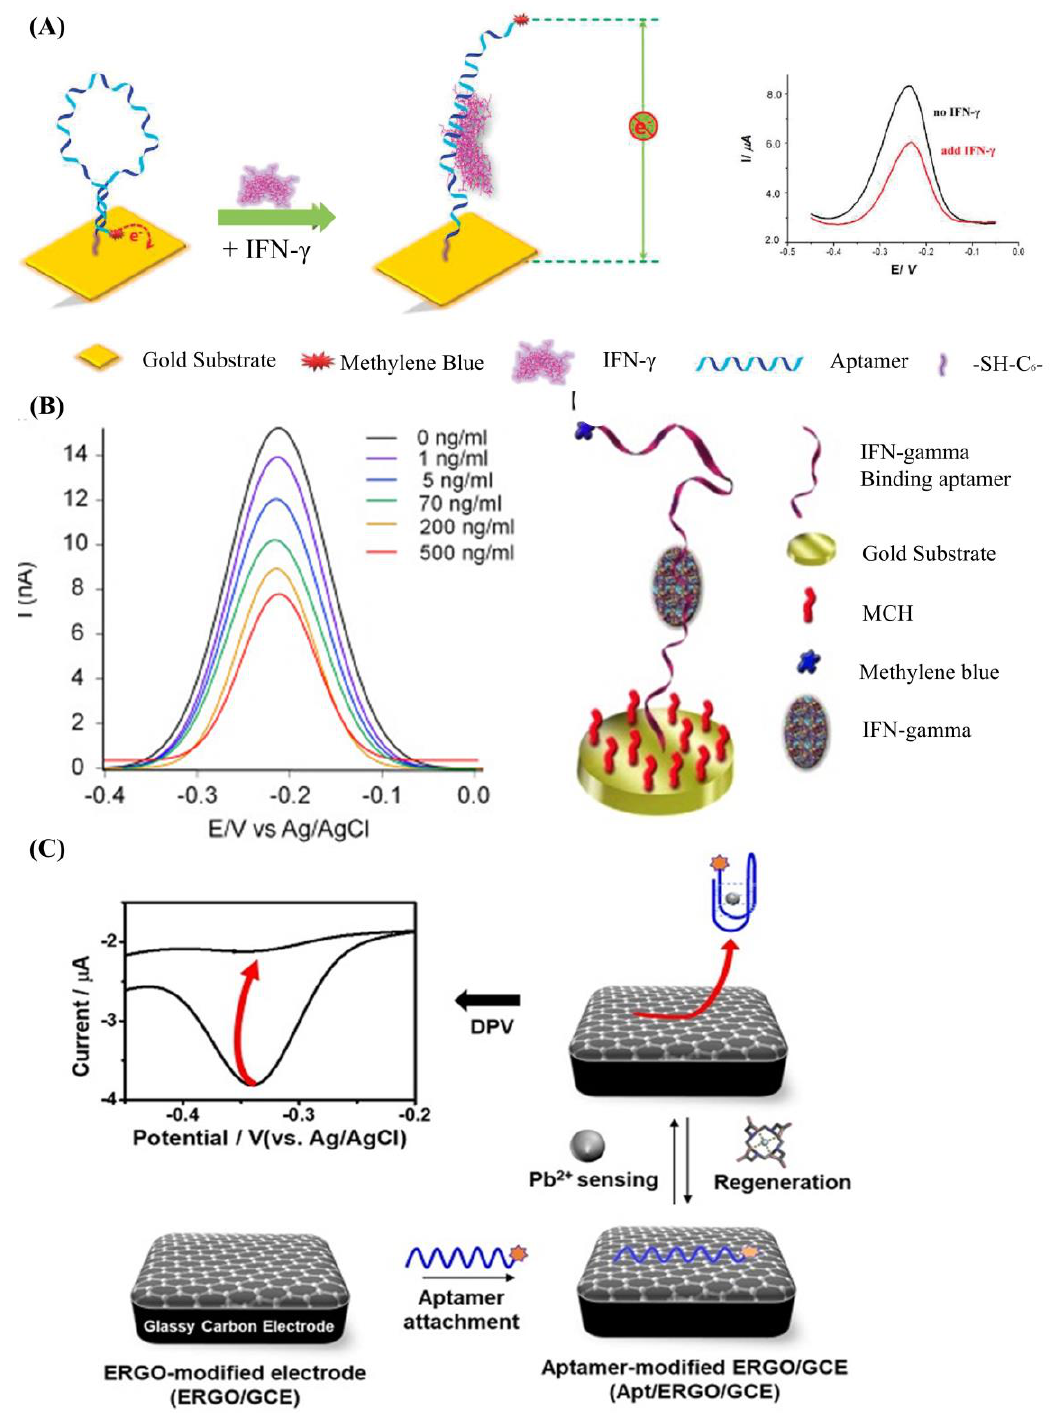
Figure 2. ( A ) Schematic of aptamer-based electrochemical sensor for IFN-γ. Reprinted (adapted) with permission from [64]. Copyright (2010) American Chemical Society. ( B ) Demonstration of the MB-tagged aptamer modified electrode. Reprinted (adapted) with permission from [65]. Copyright (2014) Elsevier. ( C ) Schematic diagram depicting the fabrication of Ap/ERGO/GCE-based electrochemical aptasensor for the detection of Pb 2+ . Reprinted (adapted) from [77]. Copyright (2019) MDPI, Basel, Switzerland, under the Creative Commons Attribution